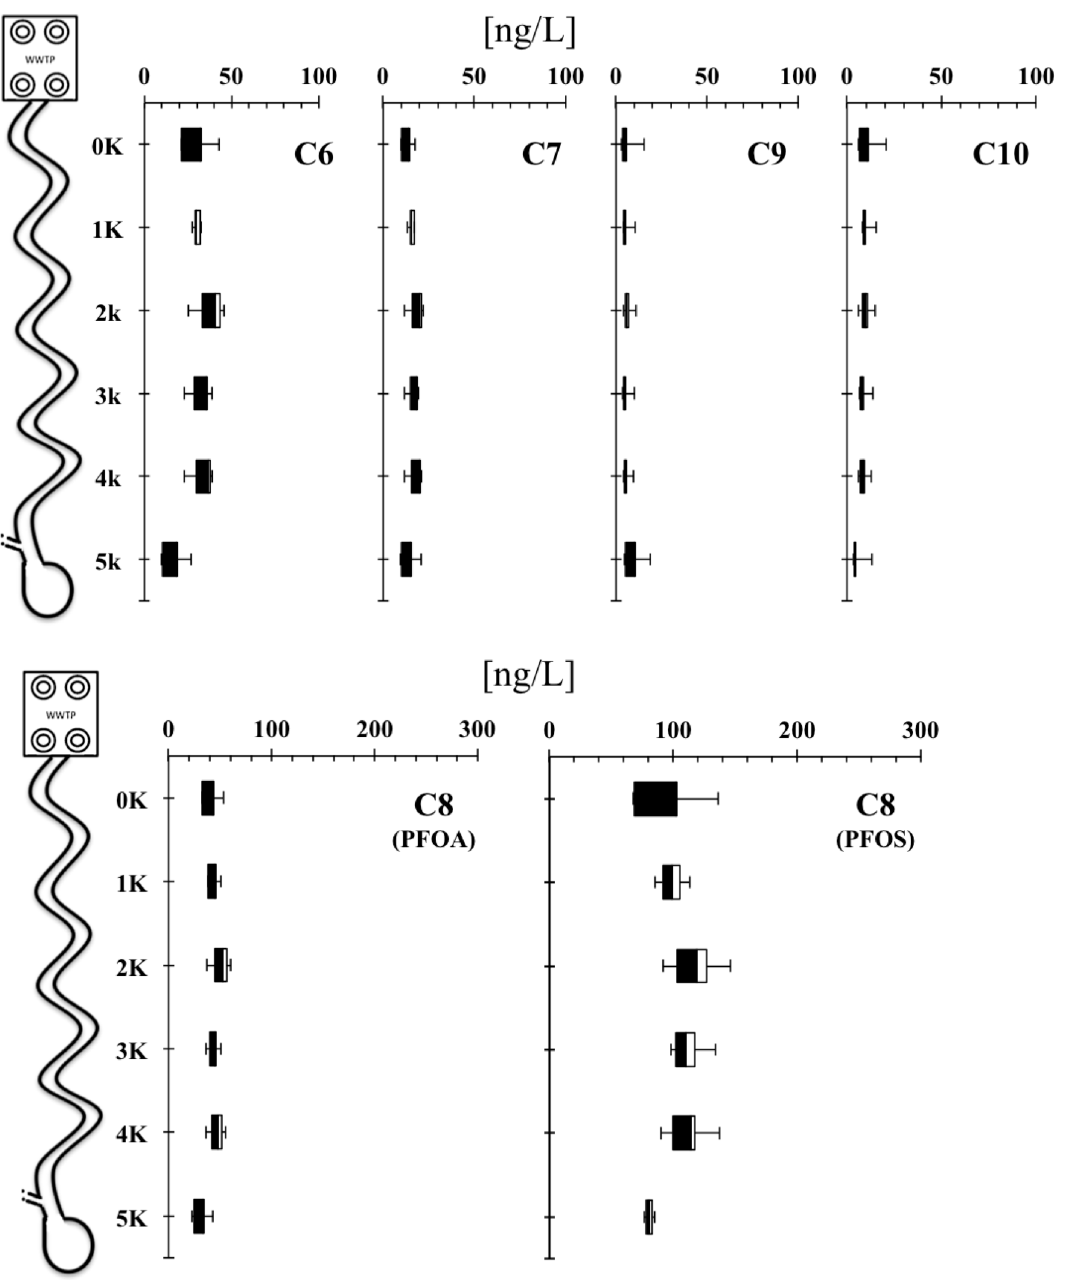
Fig 2. Longitudinal concentrations of PFAAs during the wet season. Box plot indicate minimum and maximum (bars), 225 quartile (white box), median (horizontal line), and 75 quartile (black box). No statistical differences were found for collections during the wet season.